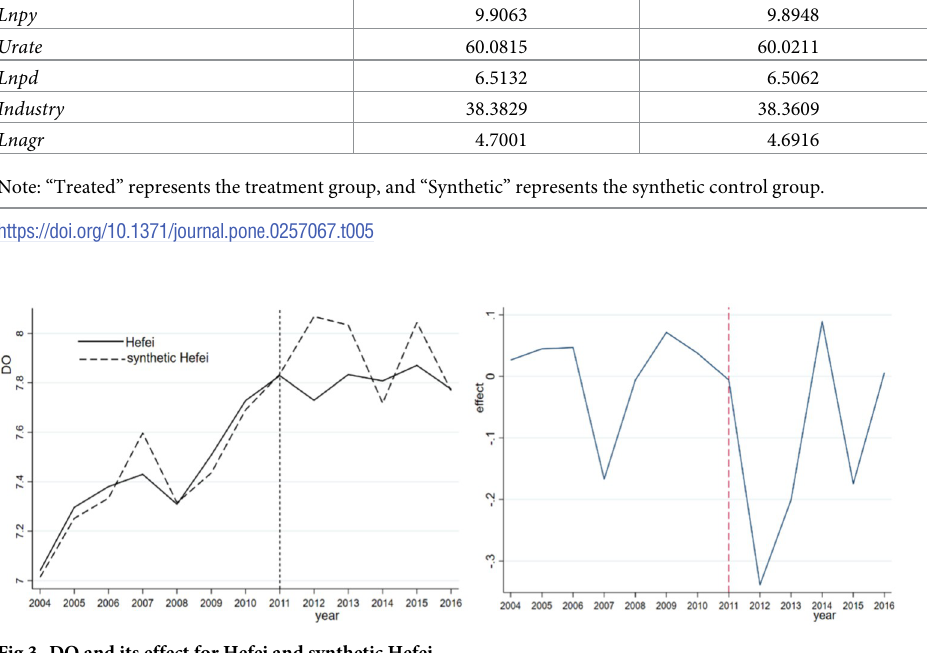
Table 6. Treatment and synthetic control groups of the predictive variables for DO. Predict Variables Treated